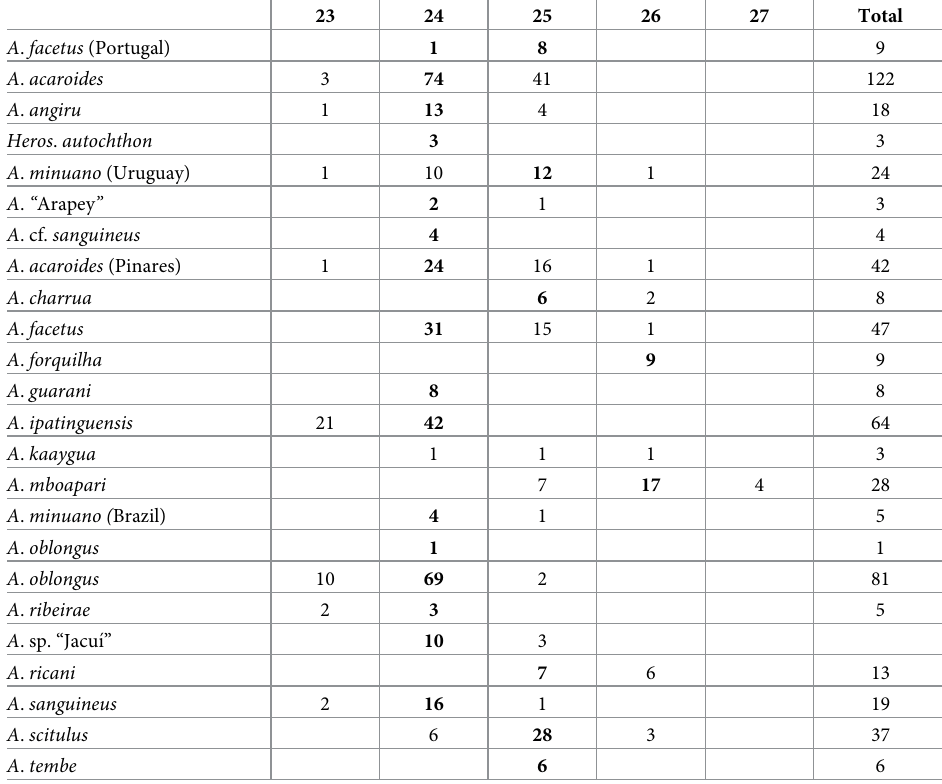
Table 4. Number of scales along the middle of the side (E1 row scales) in species of Australoheros .